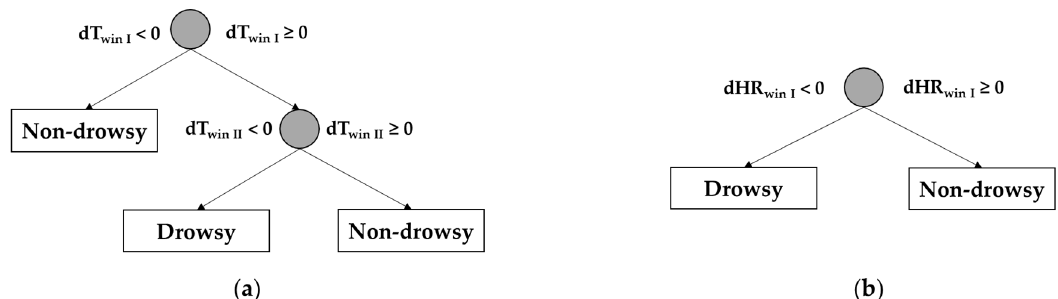
Figure 3. Schematic overview of the structure for the decision tree classification. ( a ) dT win I refers to the slope of the temperature in one of the initial windows of the measurement (number 1, 2, or 3). Accordingly, dT win II refers to the slope in either one of windows 4 to 9. As a result, the driver is labeled as “drowsy” when an increase in temperature is followed by a decrease. ( b ) dHR win I indicates the slope of the heart rate inside one of the nine windows.